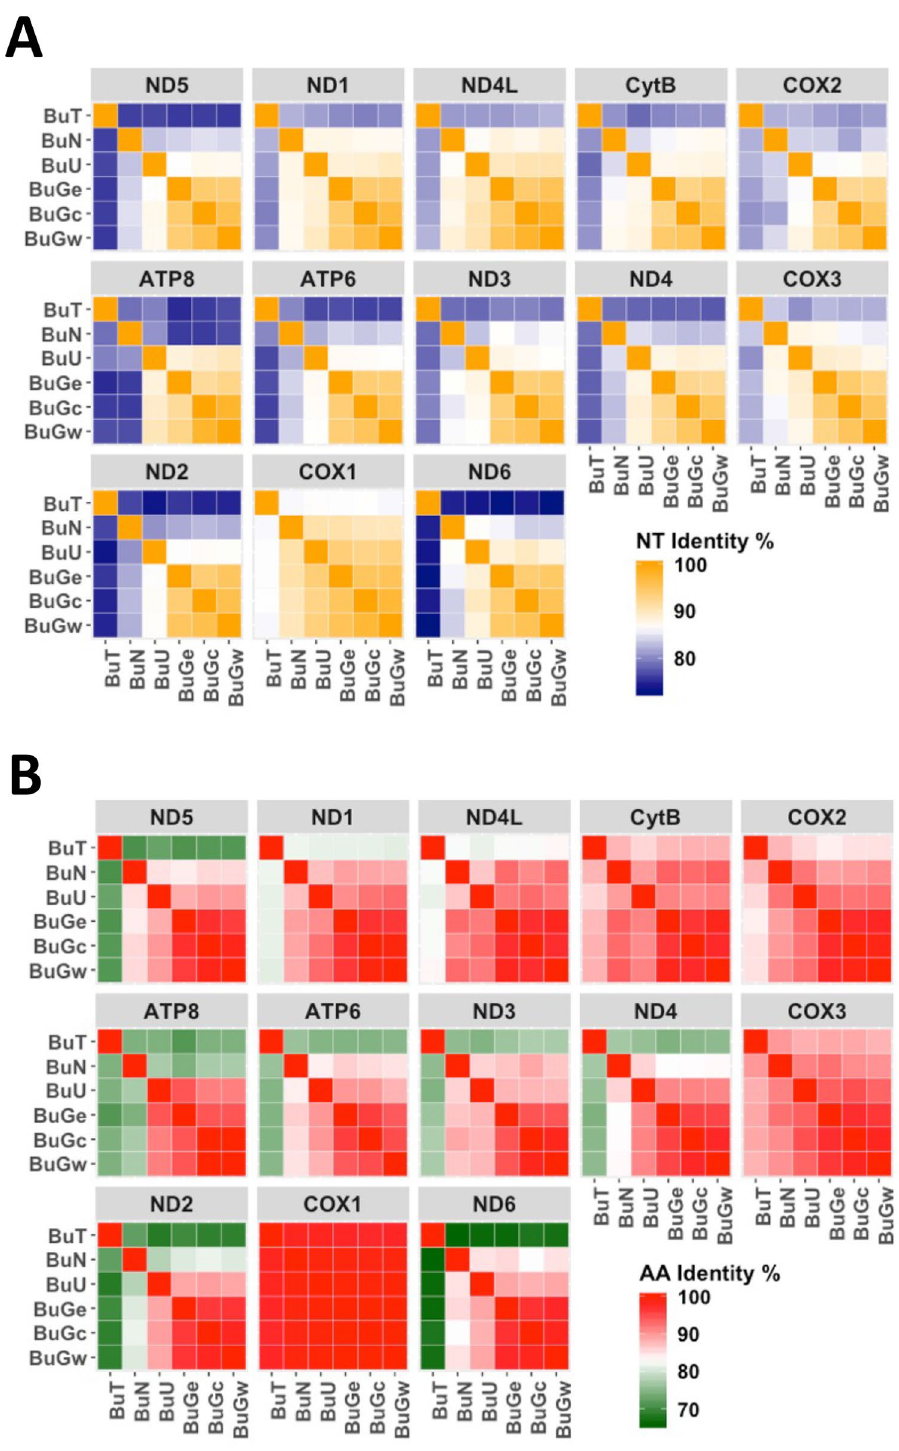
Figure 2. Heatmaps showing the degree of identity of nucleotides (nt) ( A ) and amino acids (aa) ( B ) between